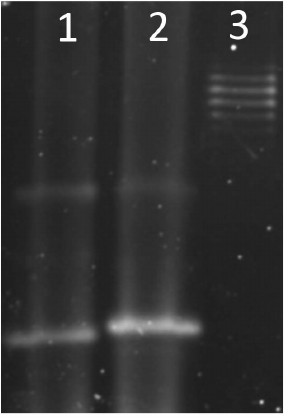
Figure 5. Lipooligosaccharide (LOS) profiles of H. parasuis strains Nagasaki and D74. LOS was extracted from H.parasuis Nagasaki (Lane 1) and D74 (Lane 2) and evaluated by electrophoresis and stained as described in Materials and Methods. LPS extracted from E. coli was included as a control (Lane 3).